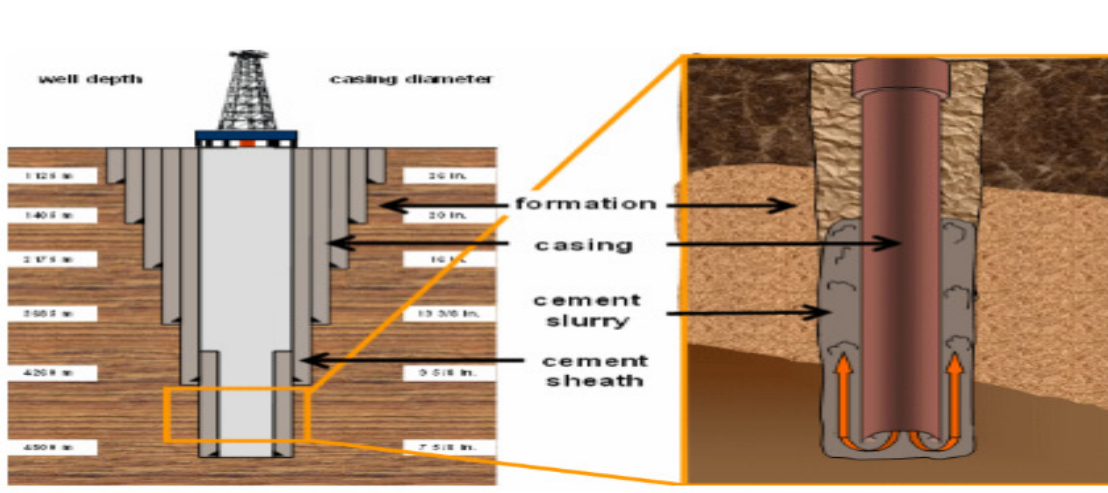
FIG. 1. PLACING THE CEMENT SLURRY BETWEEN CASING AND